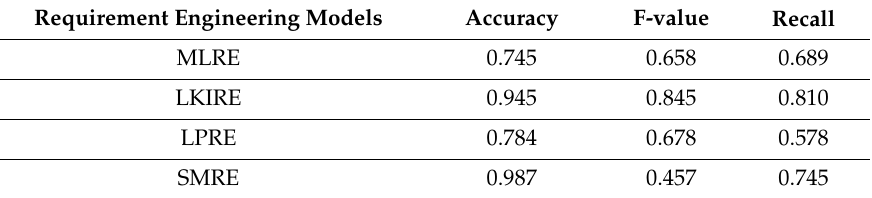
Table 3. Classification results of selected 4 requirement engineering models.